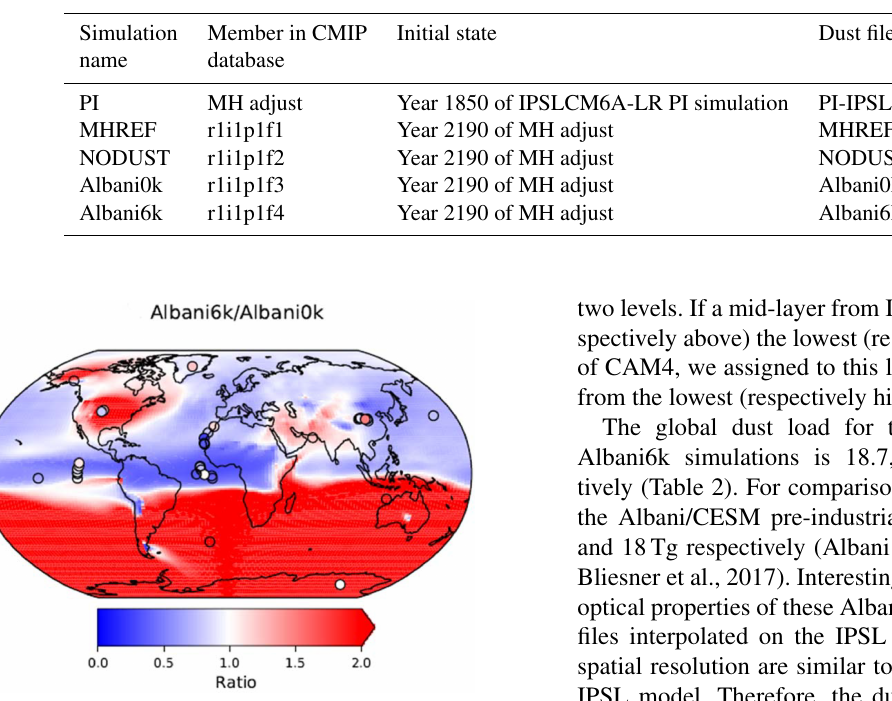
Table 1. Characteristics of the different experiments in terms of initial state, 3D dust distribution and simulation length. Albani6k is 290 instead of 300 years long. The last 10 years should have been run on a new computer with the risk to obtain non-continuous results due to the new running environment of the new computer. The second column indicates the experiment member posted on the ESGF CMIP6 database.